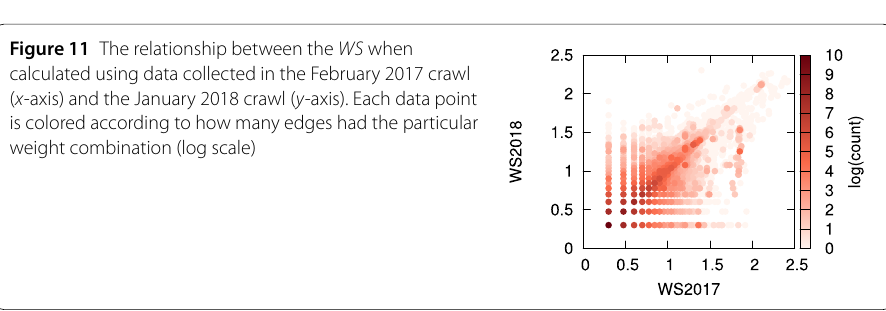
Figure 11 The relationship between the WS when calculated using data collected in the February 2017 crawl ( x -axis) and the January 2018 crawl ( y -axis). Each data point is colored according to how many edges had the particular weight combination (log